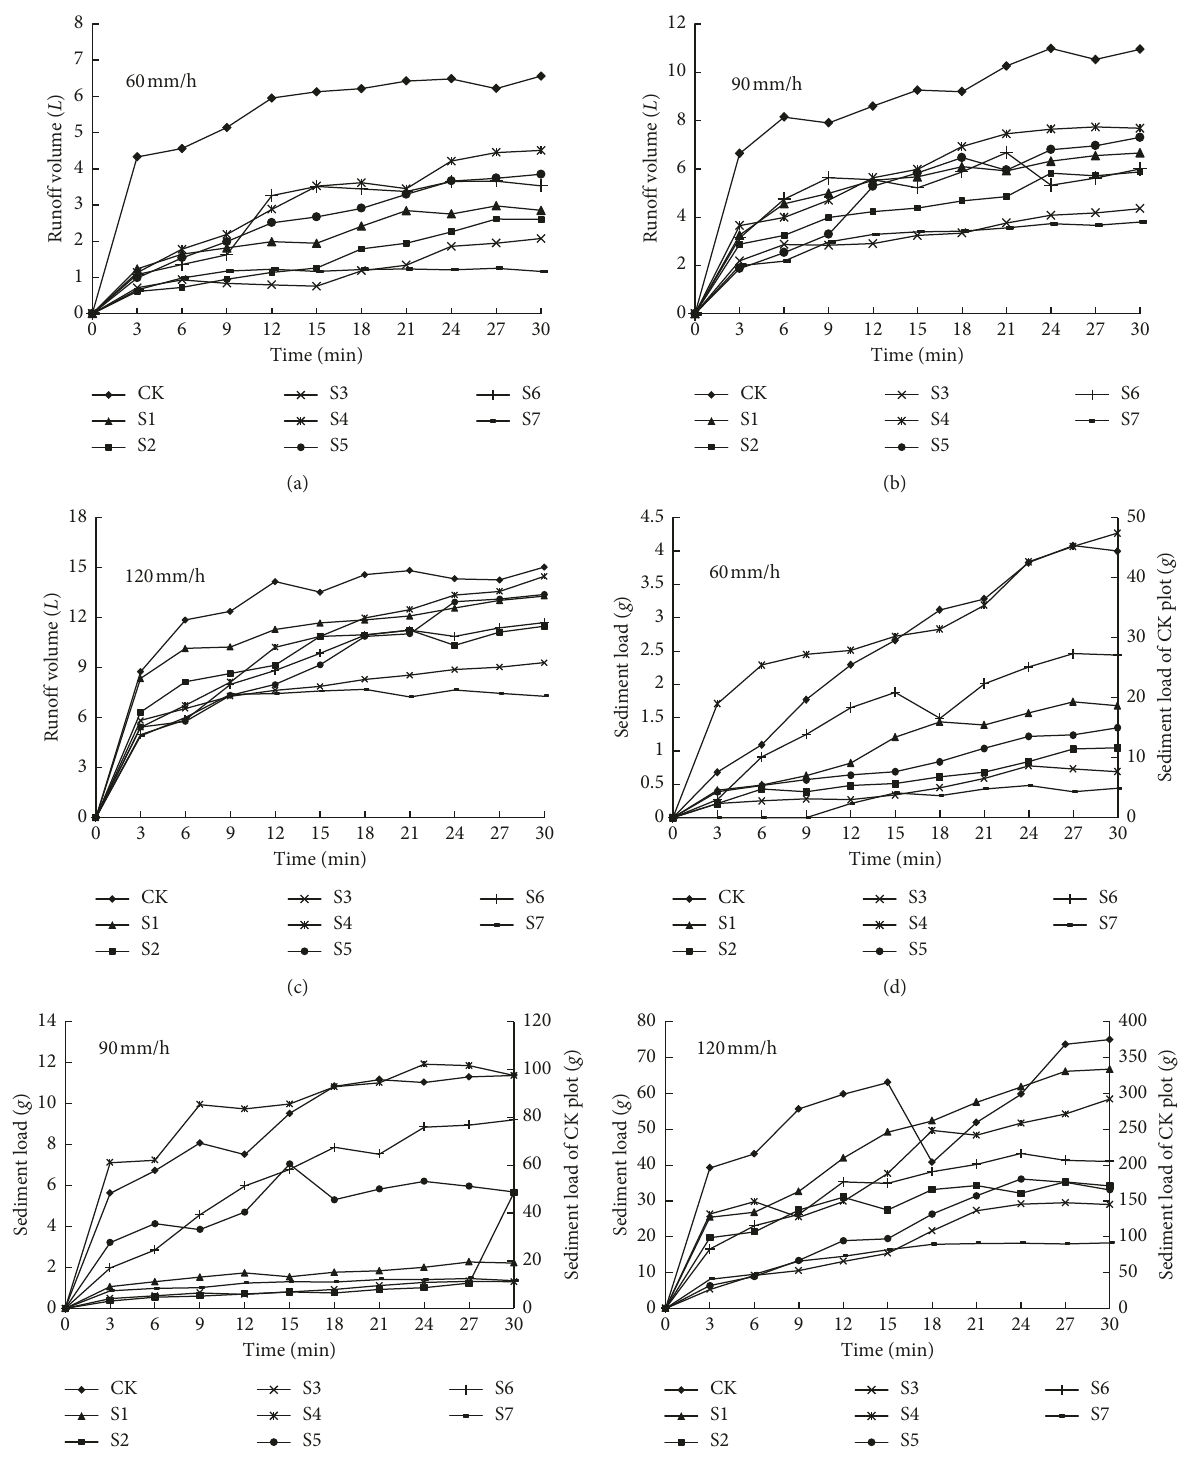
Figure 2: Changes in runoff volume and sediment loads under different rainfall intensities and vegetation